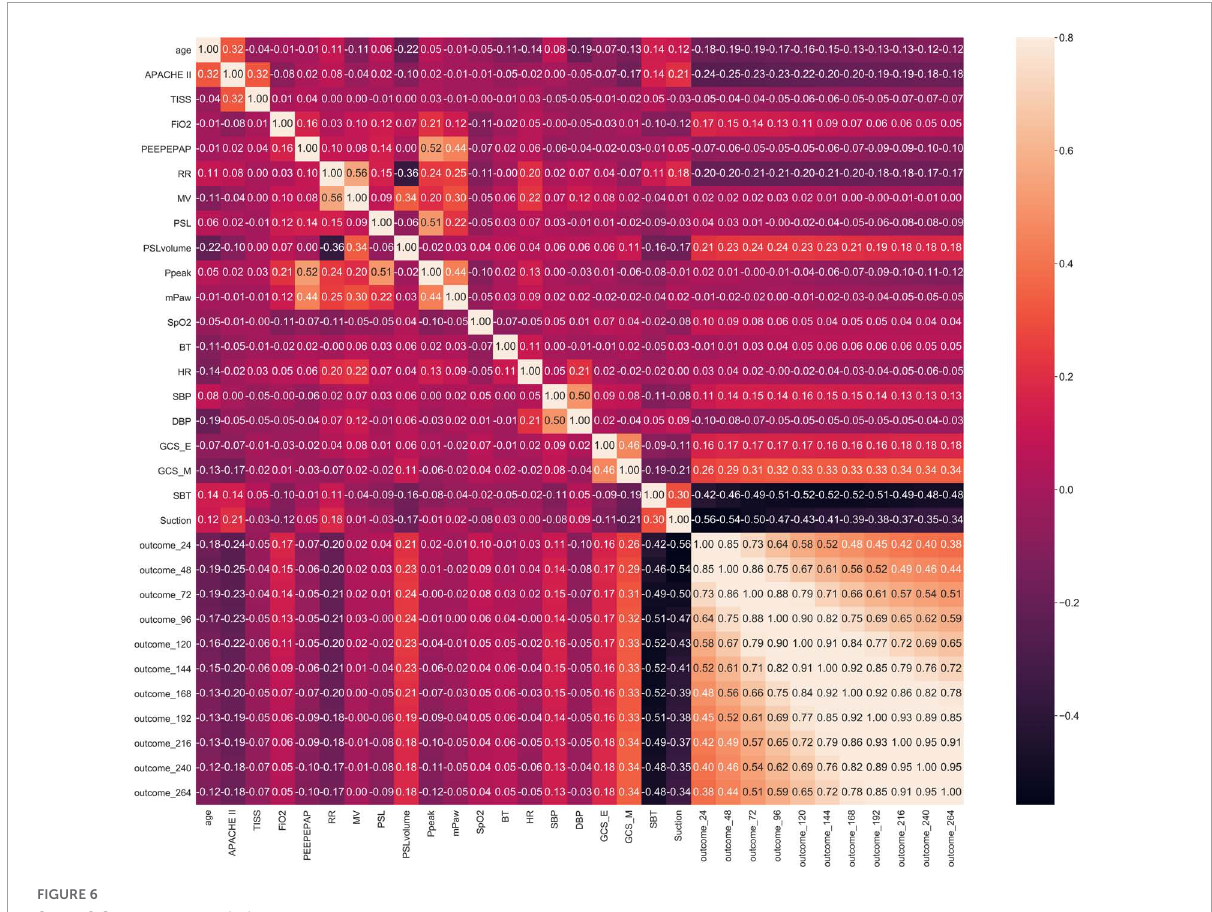
FIGURE6 Stage 2 Spearman correlation.